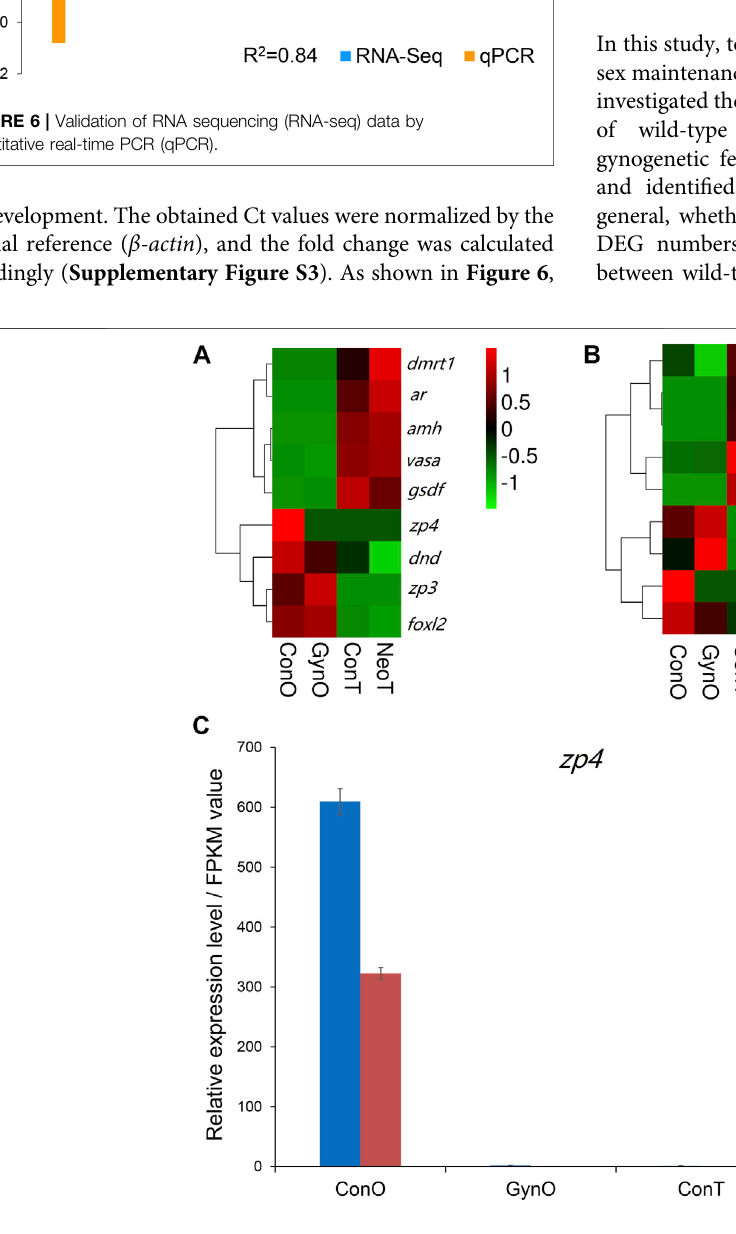
FIGURE 7 | The expression patterns of the selected genes. (A) Heatmap of selected genes in RNA sequencing (RNA-seq). (B) Heatmap of selected genes in quantitative real-time PCR (qPCR). (C) Expression patterns/fragments per kilobase of transcript per million fragments mapped (FPKM) values of zp4 in the gonads of different groups detected by qPCR and